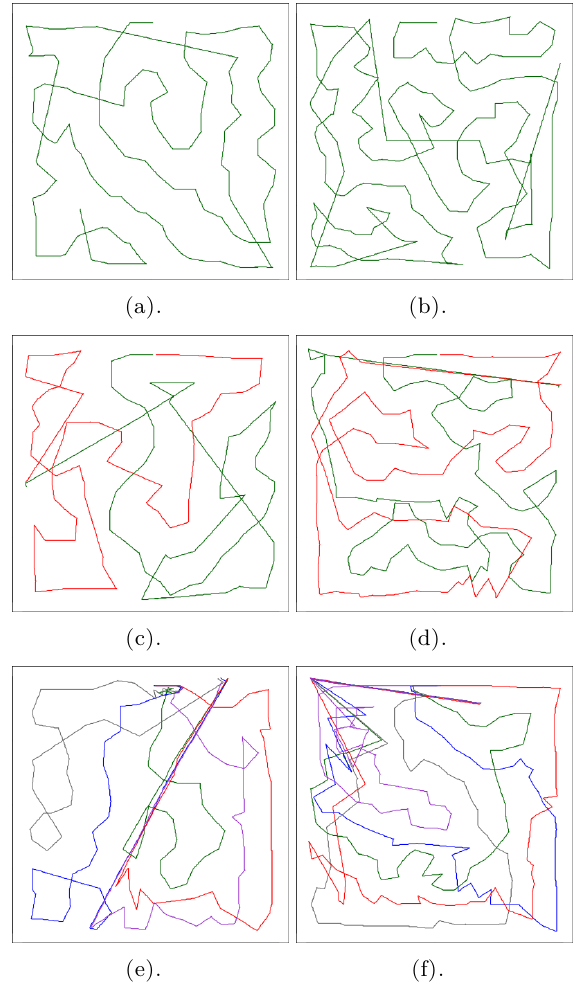
Figure 3. The resulting paths after the explo- ration. The laser range of the first column is 2 me- ters, the second column is 1.5 meters. Rows are sepa- rated by team size: (a)+(b) 1 robot; (c)+(d) 2 robots; (e)+(f) 5